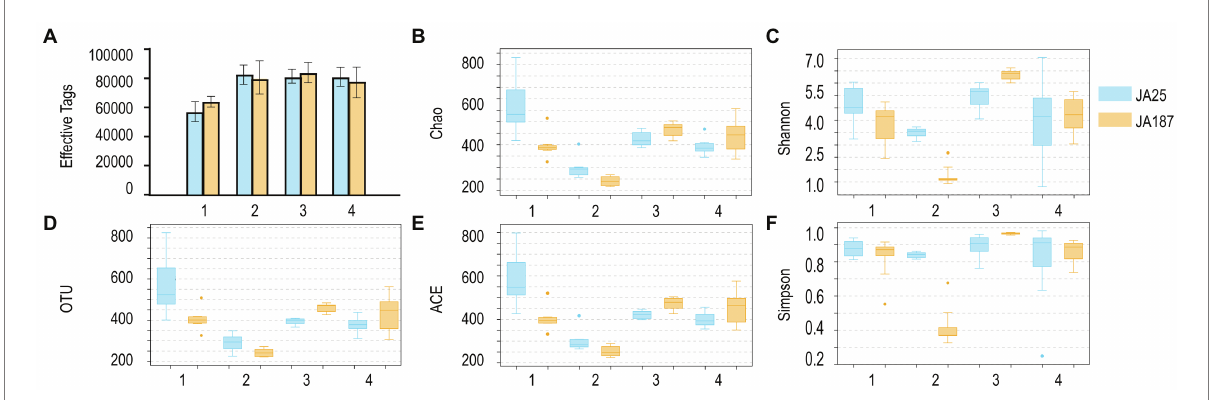
FIGURE 1 Results of the analysis of the number of effective sequences, operational taxonomic units and Alpha diversity index of bacteria on the surface of tubers of different Jerusalem artichoke resources during storage. A : Effective tags; B : Chao index; C : Shannon index; D : OTUs; E : ACE index; F : Simpson index. The numbers of replicated samples in this figure are as follows: ‘JA25’ ( n = 24), ‘JA187’ ( n = 24).